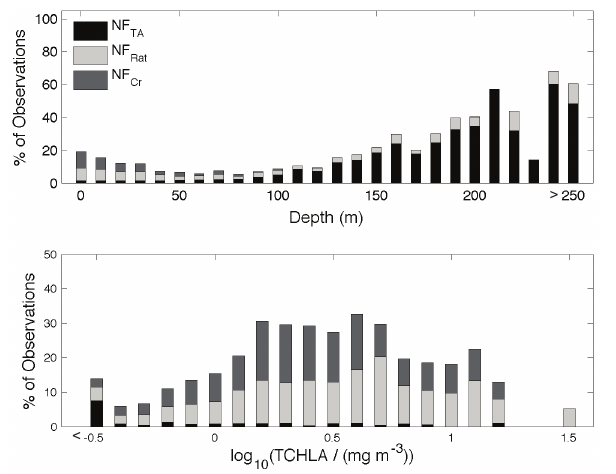
Figure 3. The percent of observations that were flagged due to each quality control measure (exclusive of samples already flagged “ F TC ” for TCHLA ≤ 0) as a function of (a) depth (m) and (b) TCHLA (mgm − 3 ). F TA indicates samples flagged for having less than four non-zero accessory pigments; F Rat indicates regression outliers of the TACC vs. TCHLA relationship; and F Cr indicates samples for which an entire cruise was flagged due to 35% or more of the cruise samples acquiring F Rat flags.